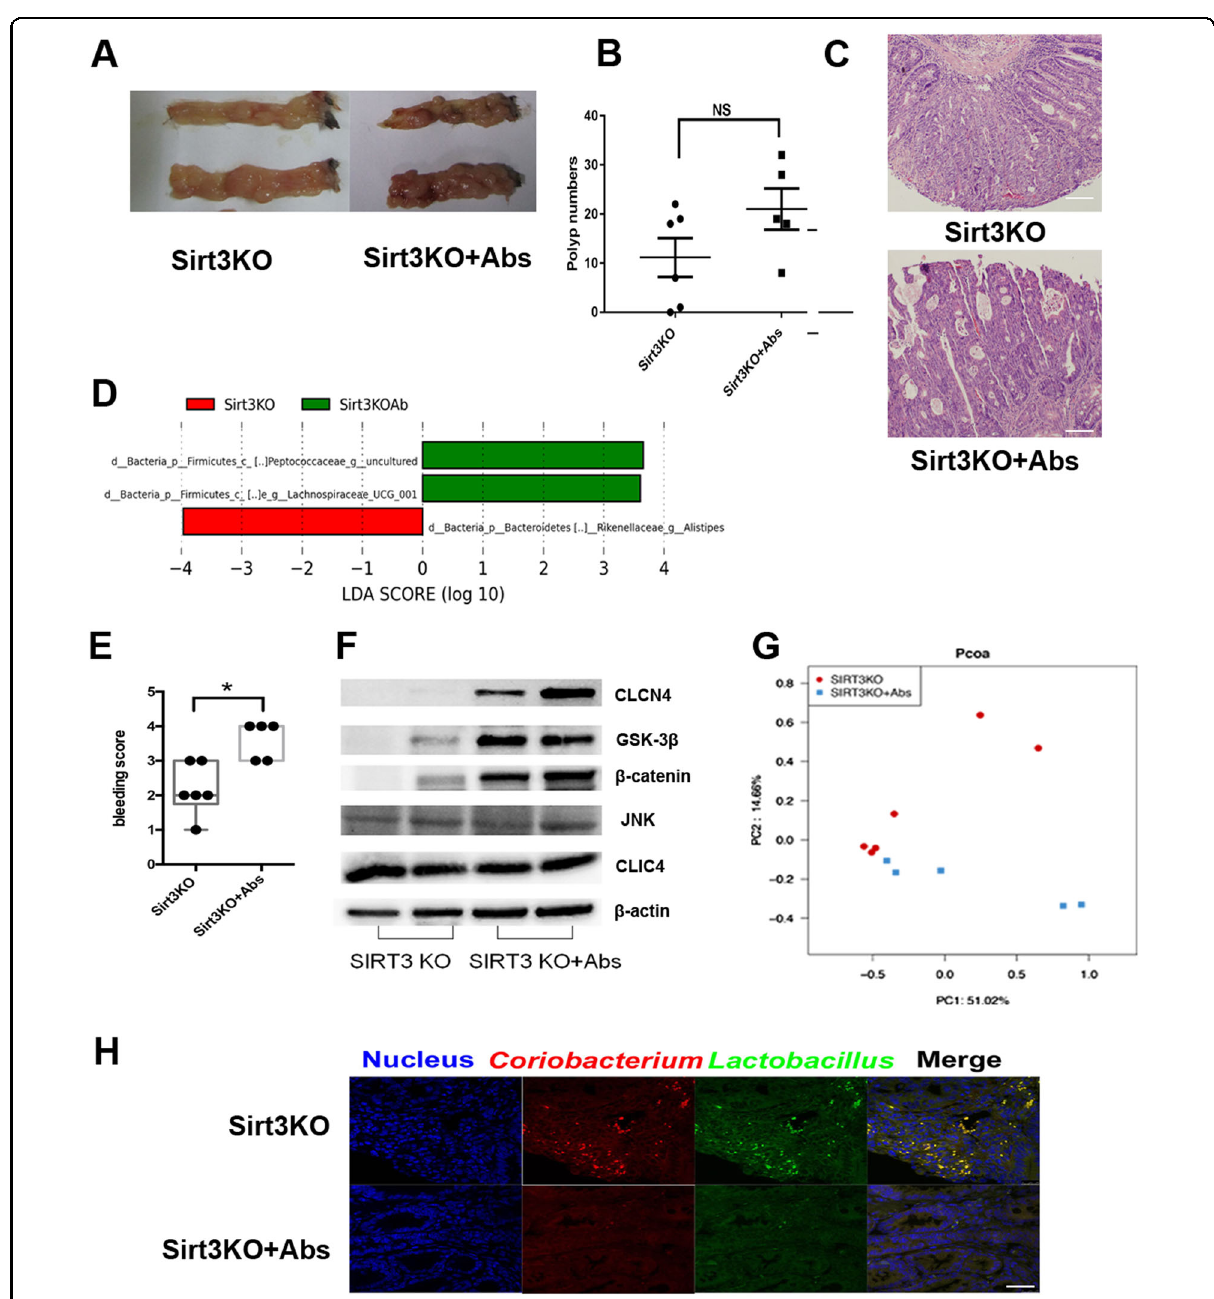
Fig. 4 Commensal microbiota protect against severe colon cancer in SIRT3KO mice. a Images of distal colons from SIRT3KO and SIRT3KO+Abs mice after AOM/DSS tumorigenesis. b Comparison of polyp numbers between SIRT3KO and SIRT3KO+Abs mice ( n = 5 – 6). The data are represented as the mean ± SEM. P < 0.05; ** P < 0.01; *** P < 0.001; by unpaired Student ’ s t test. c Representative HE staining of distal colon sections obtained from SIRT3KO and SIRT3KO+Abs mice after AOM/DSS tumorigenesis. d Featured altered microbial communities between SIRT3KO and SIRT3KO+Abs mice after AOM/DSS tumorigenesis ( n = 5 – 6) from Illumina Miseq sequencing. Data were analyzed by the Mann – Whitney test. e Fecal occult blood tests of SIRT3KO and SIRT3KO+Abs mice ( n = 5 – 6). f PCoA of 16S rRNA gene-sequencing analysis of gut microbes obtained from the SIRT3KO and SIRT3KO +Abs mice ( n = 5 – 6) from Illumina Miseq sequencing. PC1 and PC2 explain 51.02 and 14.66% of the variation, respectively. g Western blots of intestinal CLCN4, JNK, CLIC4, GSK3 β and β -catenin expression from SIRT3KO and SIRT3KO+Abs mice after AOM/DSS tumorigenesis. h FISH with Lactobacillus (green) and Coriobacterium (red) from distal colons of SIRT3KO and WT mice after AOM/DSS tumorigenesis. n no signi fi